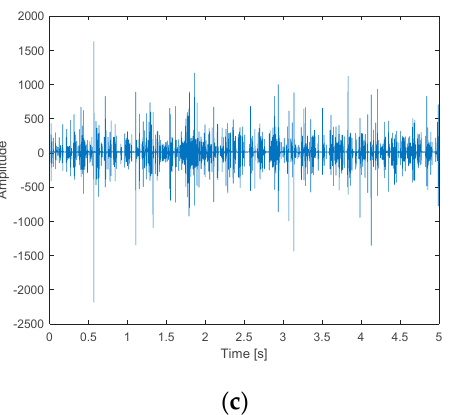
Figure 10. Waveforms of the reconstructed cylinder vibration signals: ( a ) working condition 1; ( b ) working condition 2; ( c ) working condition 3.